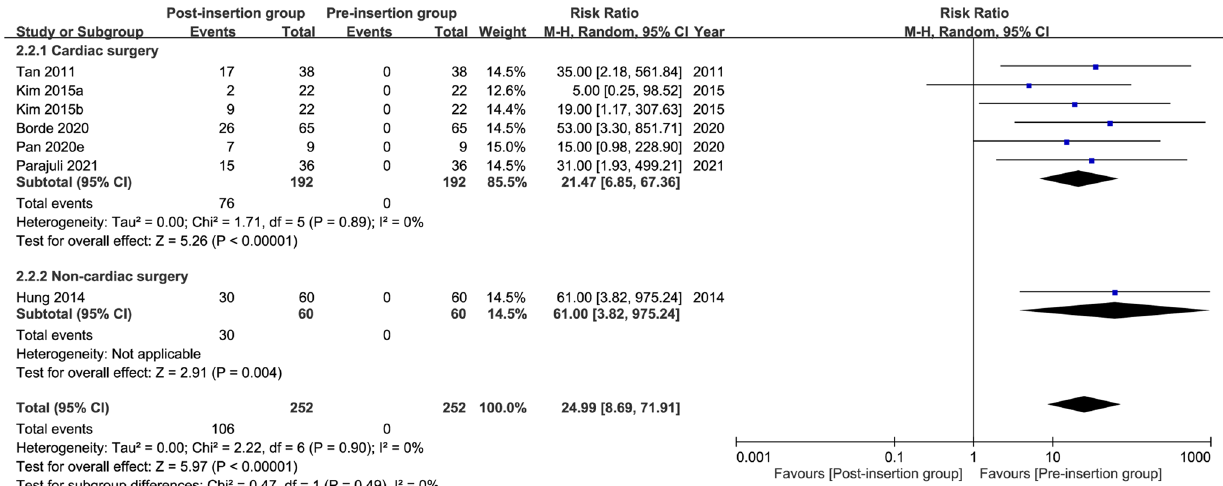
Figure 4. Forest plot comparing the risk of high cuff pressure after esophageal medical device insertion in adults undergoing cardiac and non-cardiac surgery. CI confidence interval; M–H Mantel–Haenszel.